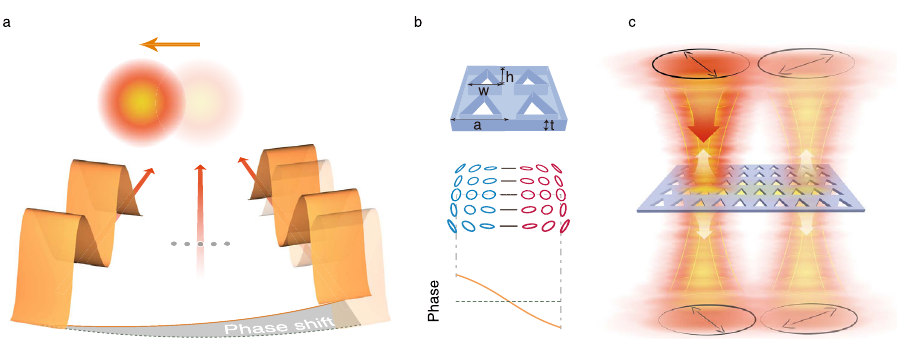
Fig. 1 Concept of realizing polarization-dependent lateral shifts of normally-incident Gaussian beams via photonic crystal (PhC) slabs. a Schematic view of a beam shift caused by a momentum-space phase gradient. A beam can be viewed as a superposition of plane waves. When an additional phase gradient is introduced to the plane waves in momentum space, the beam will be shifted in the real space in the opposite direction of the gradient. b Illustrations of the applied design of a PhC slab which has no in-plane inversion symmetry (upper panel), the corresponding structure of polarization eigenstates near the center of the momentum space (middle panel), and the geometric phase distribution introduced by the PhC slab along the k x direction with a (cid:2) 45 j i -polarized incident beam (lower panel). c Schematic view of a lateral shift realized by the designed PhC slab. A (cid:2) 45 j i polarized beam is normally shined, and after the scattering process, the scattered fi eld can be viewed as four scattered beams: the directly transmitting and re fl ecting beams and the cross-polarization-converted transmitting and re fl ecting beams. The cross-polarization-converted beams will be shifted towards the direction opposite to the momentum-space phase